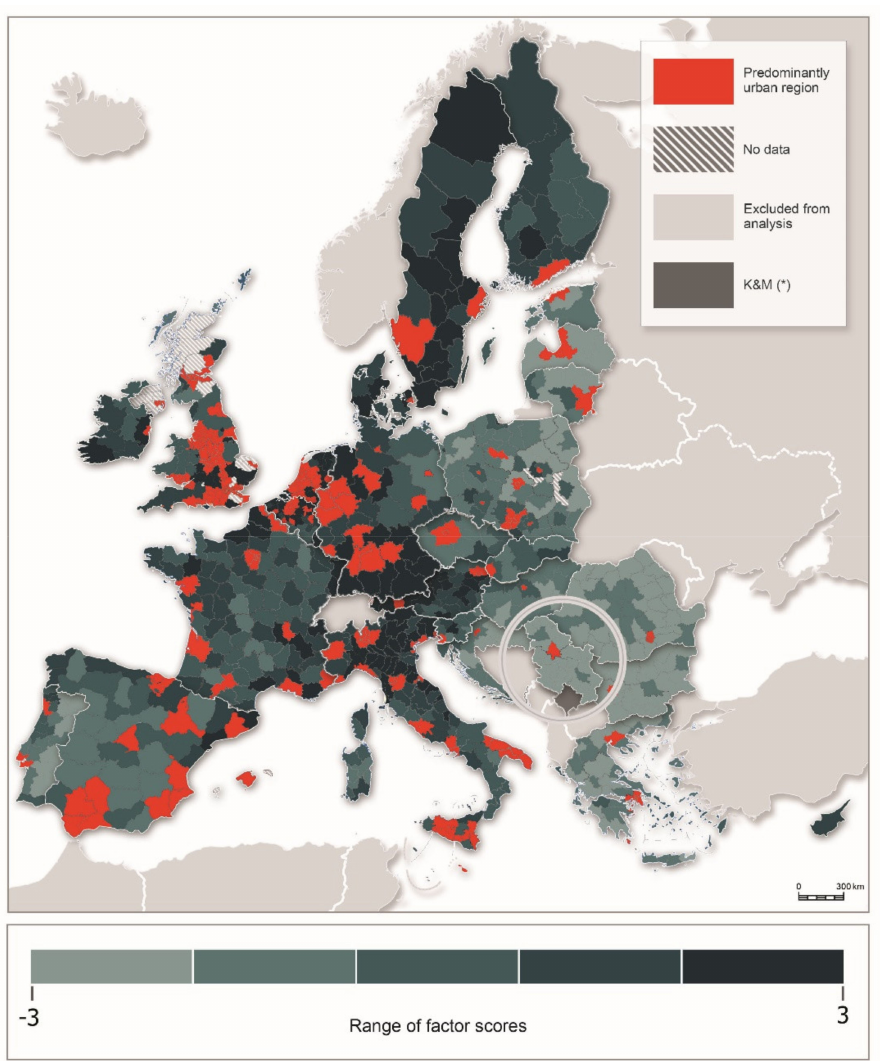
Figure 1. Index of Socioeconomic Performance of regions in EU plus Serbia as candidate for mem- bership. Source: Author processed based on results of FA. Note: The specific status of Kosovo and Metohija excluded it from the analysis. Adobe Photoshop CC 2015 and NUTS 3 maps of the European Commission were